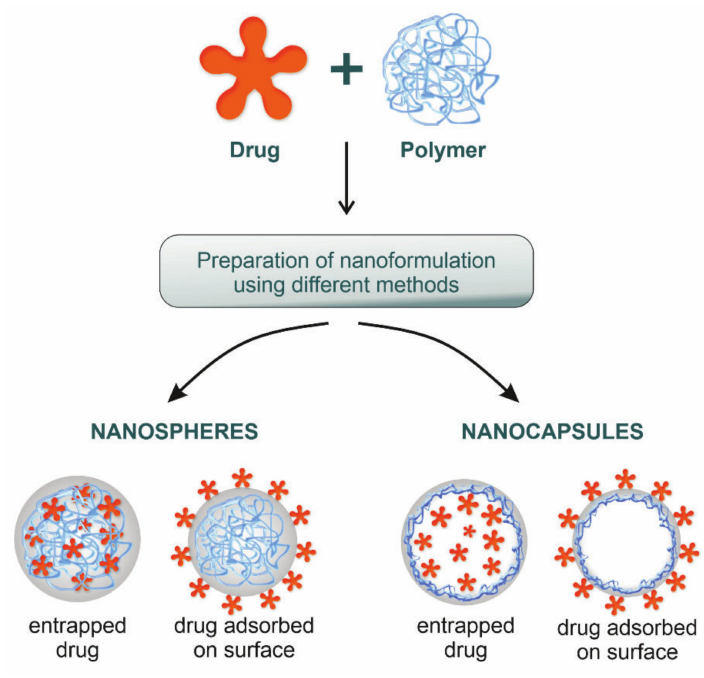
Figure 1. Types of structural forms of polymeric